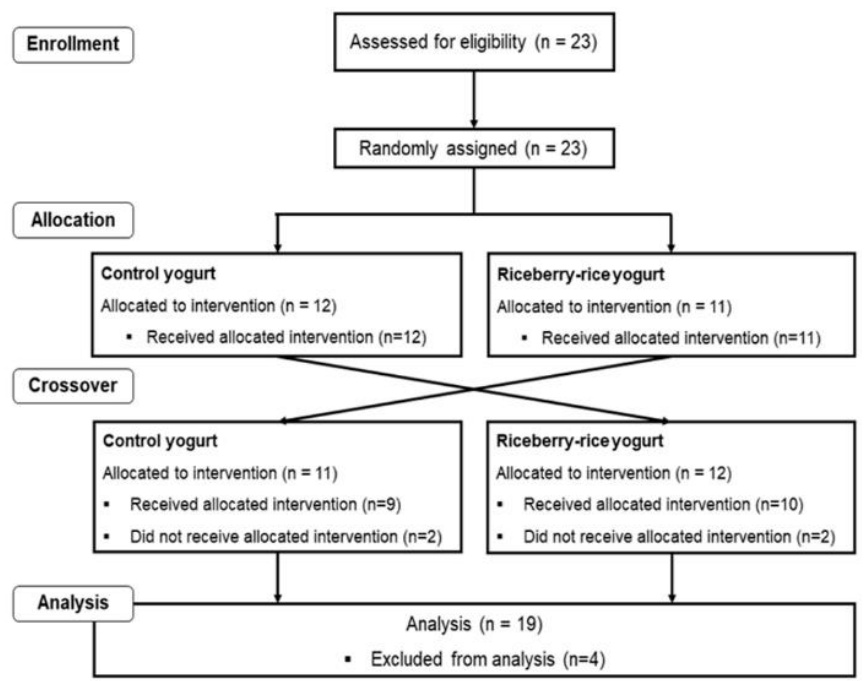
Figure 1. Figure 1. Consolidating Standards of Reporting (CONSORT) flow diagram of selection of study participants. Table 2. Baseline characteristics of Table 2. Baseline characteristics of participants.